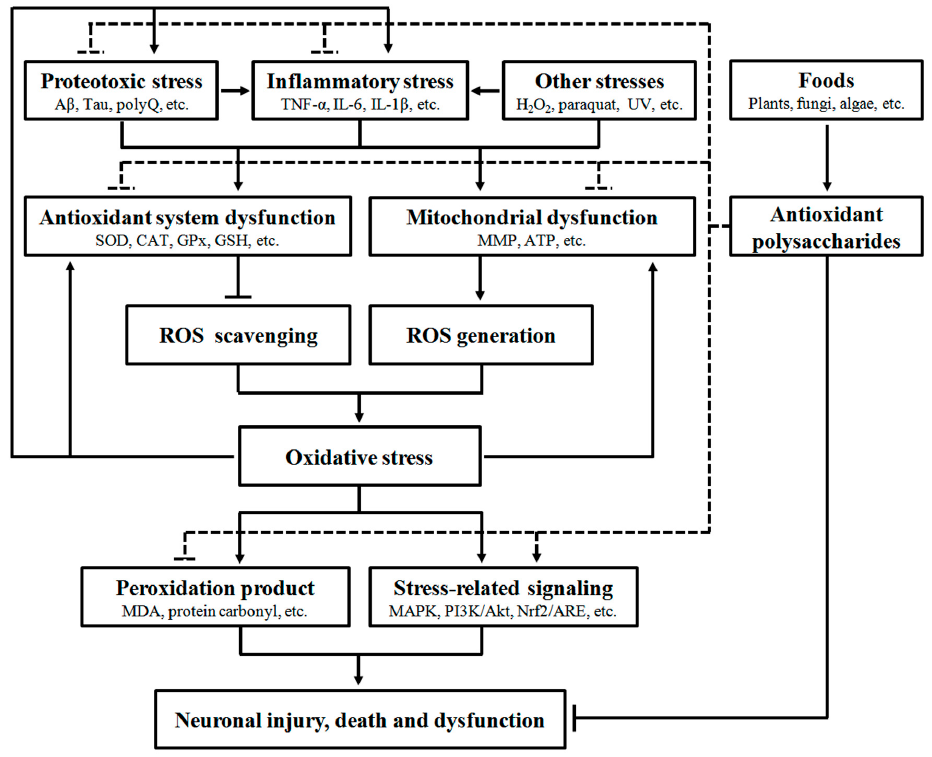
Figure 1. Pharmacological intervention of neurodegeneration by food-derived antioxidant polysaccharides. A number of extrinsic and intrinsic stresses such as proteotoxic stress, inflammatory stress and chemical interruption can stimulate oxidative stress through impairing the function of antioxidant system and mitochondria. Increase of oxidative stress can promote pathogenic protein aggregation and inflammation, eventually leading to neuronal injury, death and dysfunction via multiple biochemical pathways (solid line). However, food-derived antioxidant polysaccharides can exert beneficial effects to suppress neurodegeneration via attenuating oxidative, inflammatory and proteotoxic stresses and regulating stress-related signaling (dashed